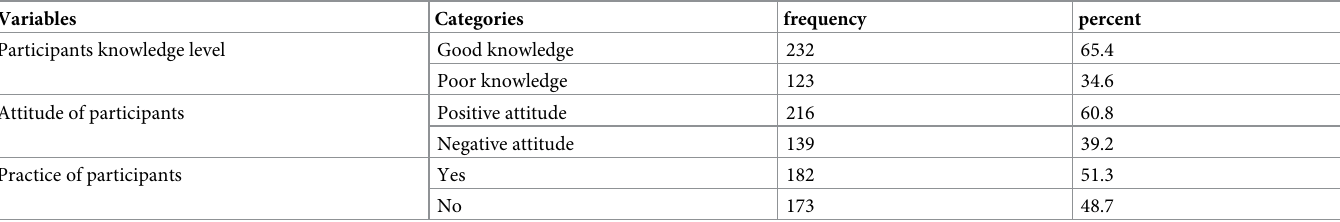
Table 2. Knowledge, attitude, and practice of the health care professionals towards complementary and alternative medicine in selected primary health care unit in Hadiya Zone, Southern Ethiopia, April, 2021 (n = 335).